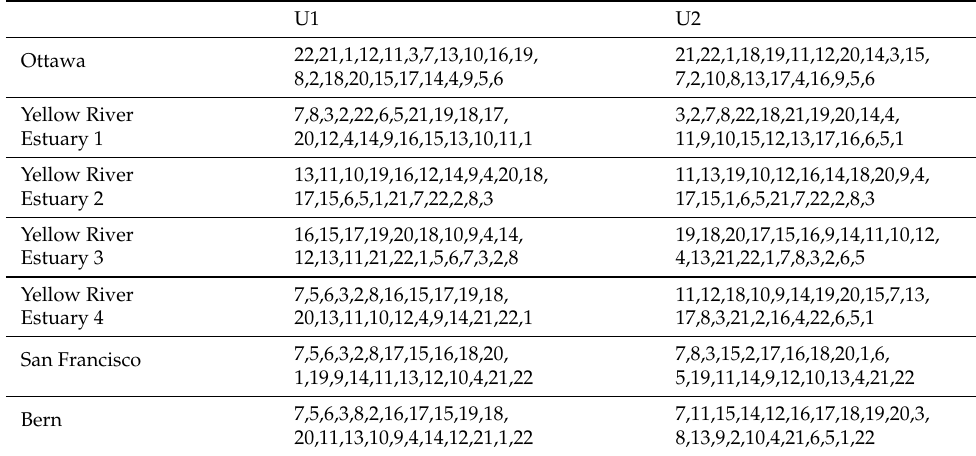
Table 5. Ranking of Utility Values for Image Pairs.